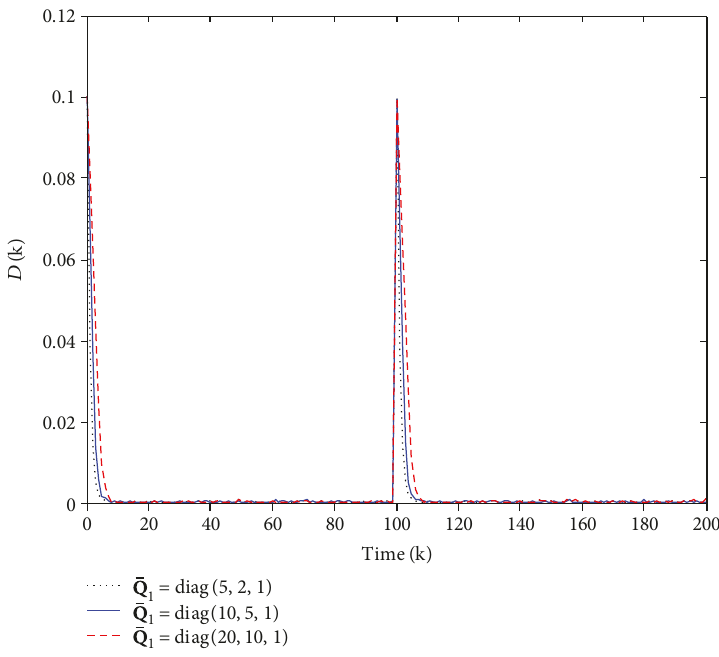
Figure 4: The comparison results of di ff erent Q